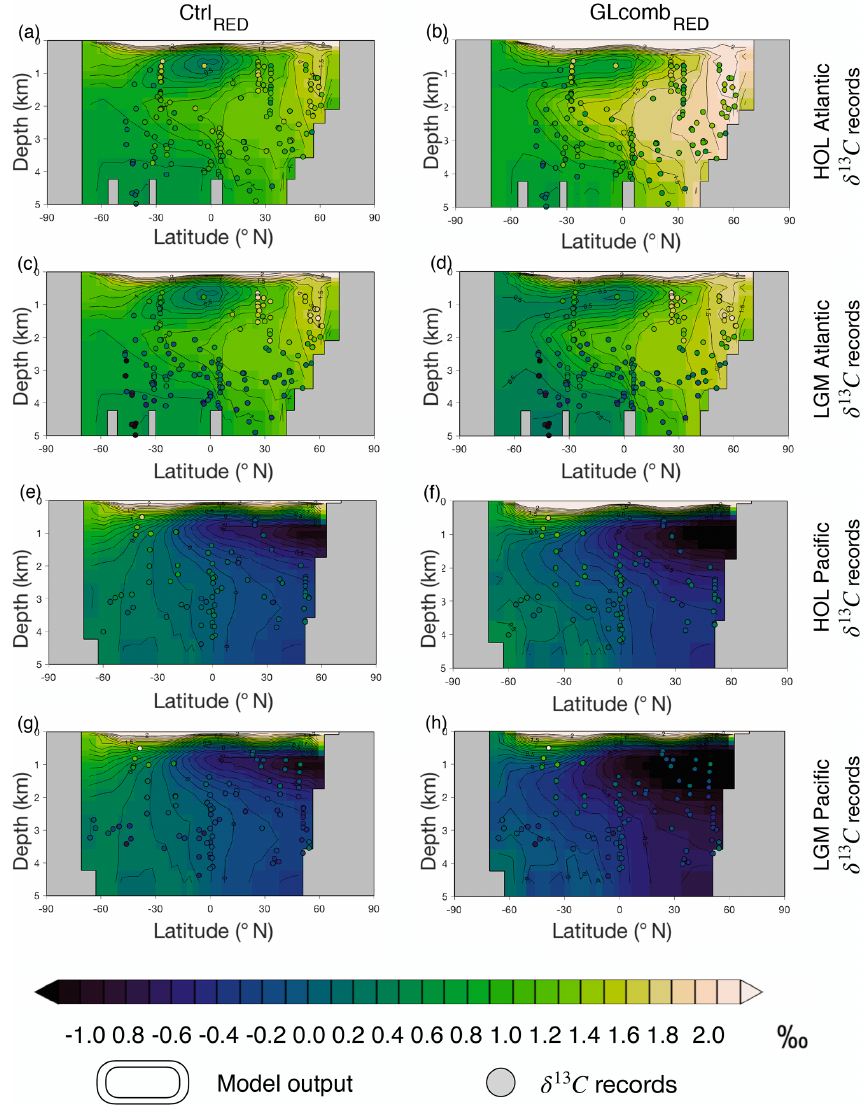
Figure 5. Model ocean δ 13 C (contours) compared to the two proxy record time slices (HOL and LGM) of benthic δ 13 C (circles) of Peterson et al. (2014). The upper half of the figure shows the Atlantic Ocean (a–d) , while the lower half shows the Pacific Ocean (e–h) . The columns represent the model simulations (Ctrl RED or Ctrl GAM ), while each row represents one of the proxy record time slices (HOL or LGM). The left-hand column shows Ctrl RED (a, c, e, g) and the right-hand column shows GLcomb RED (b, d, f, h) . The rows show, from top to bottom, (a, b) HOL Atlantic, (c, d) LGM Atlantic, (e, f) HOL Pacific, and (g, h) LGM Pacific. Note that, before we compare GLcomb RED to LGM observations (d, h) , a constant of 0.32‰ is subtracted from the simulated δ 13 C, to account for terrestrial release of δ 13 C-depleted terrestrial carbon which is not modelled. The corresponding comparison for model version GAM is shown in Fig.